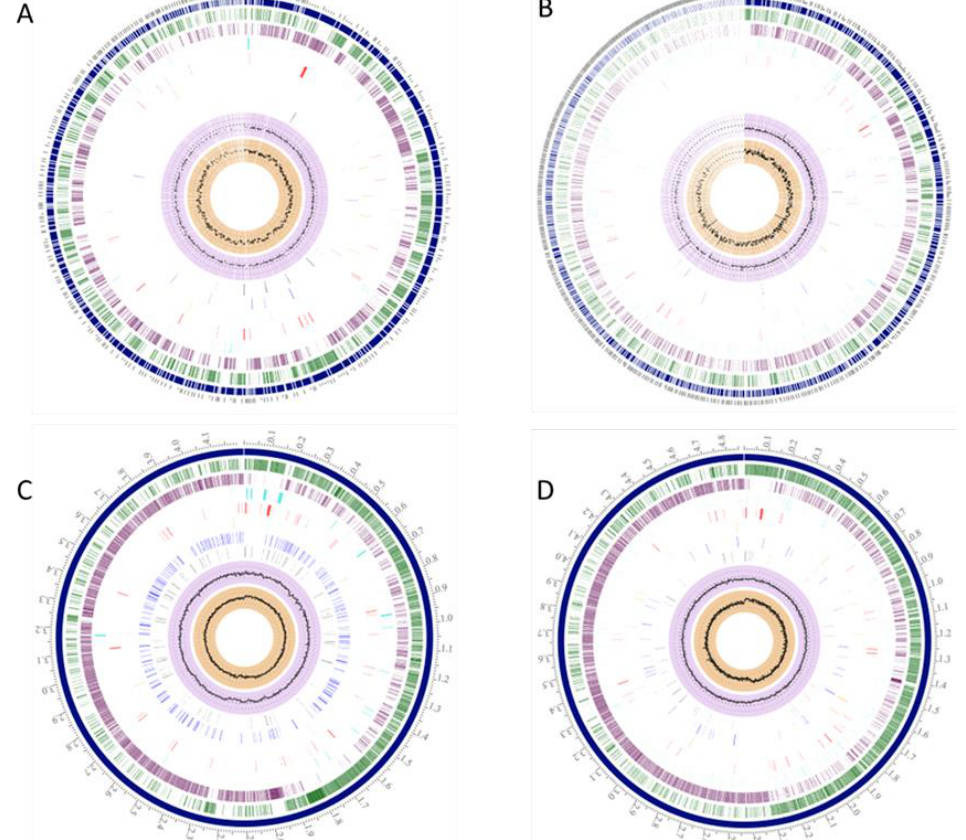
Figure 1. B. sporothermodurans SA01 ( A ), B. oleronius ( B ), B. subtilis subsp. subtilis str. 168 ( C ), and B. cereus ATCC 10987 ( D ) possess unique genomic regions in comparison with each other. The outer circle designates the genome’s coordinates in mega base pairs (Mbp). The blue circle denotes the number of contigs, and the green and purple circles represent the coding sequences (CDS), forward and reverse, respectively, with white spaces between the CDS accounting for hypothetical proteins. Non-CDS features are shown by the light blue circle. The proceeding red and orange circles represent regions encoding antimicrobial determinants and virulence factors, respectively. The two inner black circles depict the G + C contents and the skew.